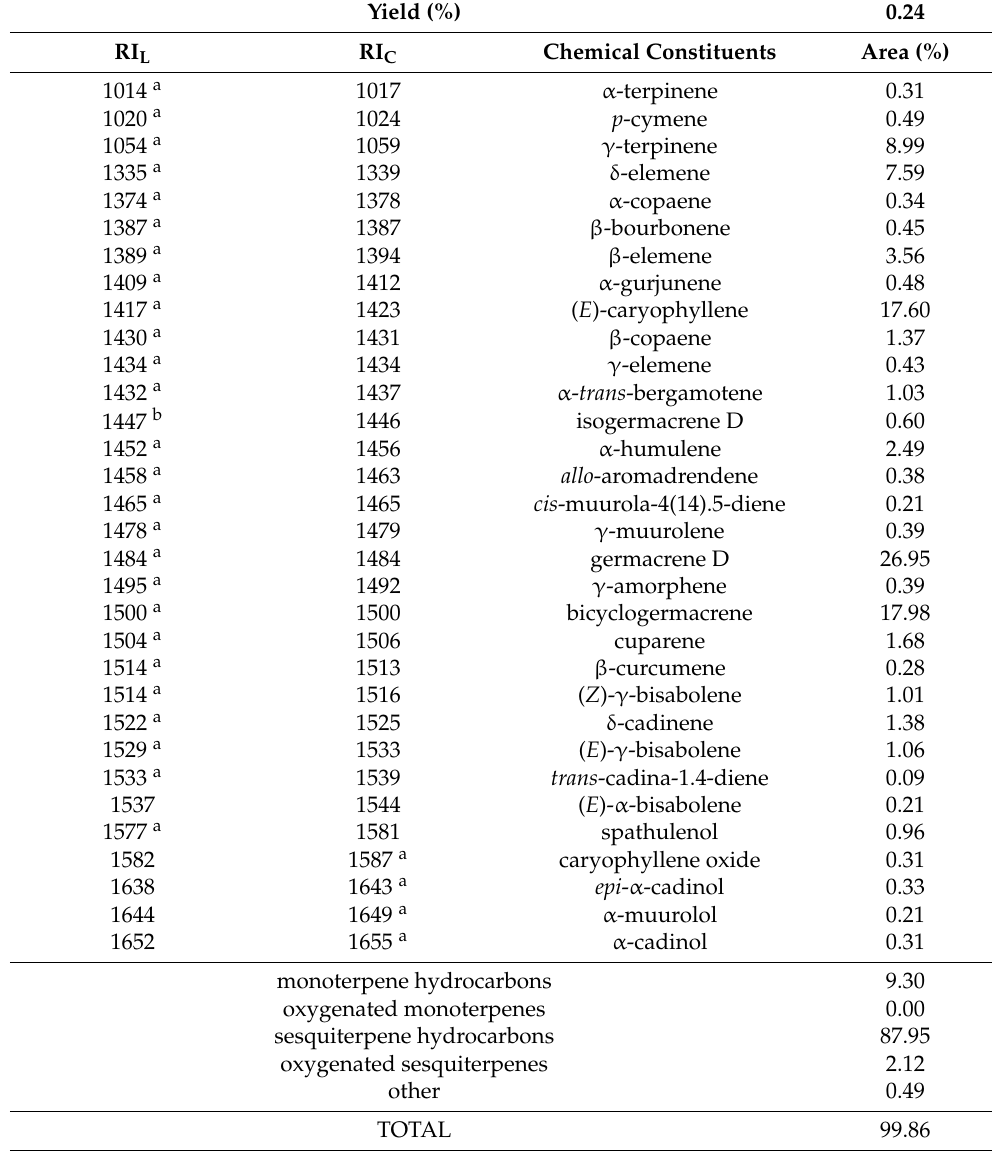
Table 1. Main chemical constituents and EO yield of C. campinarensis